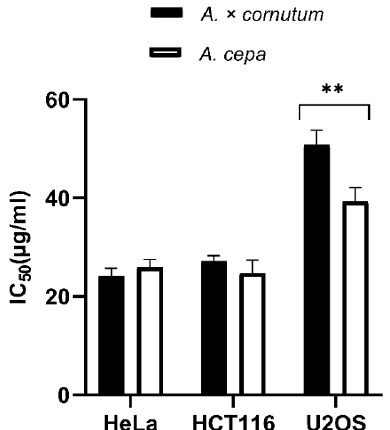
Figure 1. Antiproliferative activity of A. cornutum and A. cepa extracts against three human cancer cell lines: Hela, HCT116, and U2OS. The statistical significance was assessed by two-way ANOVA, followed by Dunnett’s multiple-comparisons test. The presented IC 50 are mean values of at least three independent experiments performed in quadruplets, with SD presented with error bars, and significant levels comparing A. cornutum with A. cepa are marked as ** p < 0.01 (Data S4).